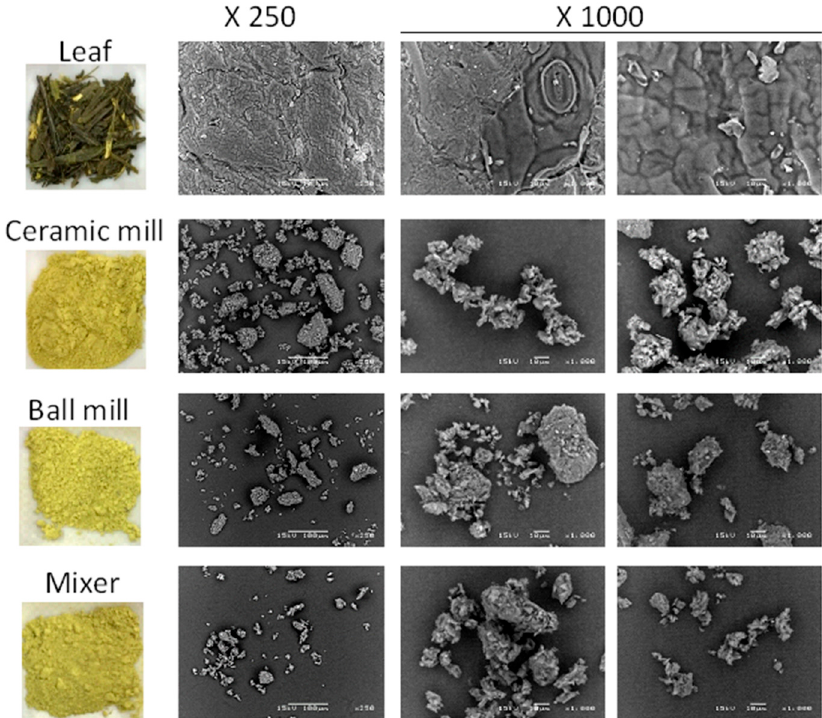
Figure 1. Appearance of green tea leaf and powder produced with different powdering method. Left panel (color) shows the photograph of green leaf and the powders produced with indicated powdering process. Right panel (monochrome) shows the images of leaf and the powders using the scanning electron microscope at indicated magnification.